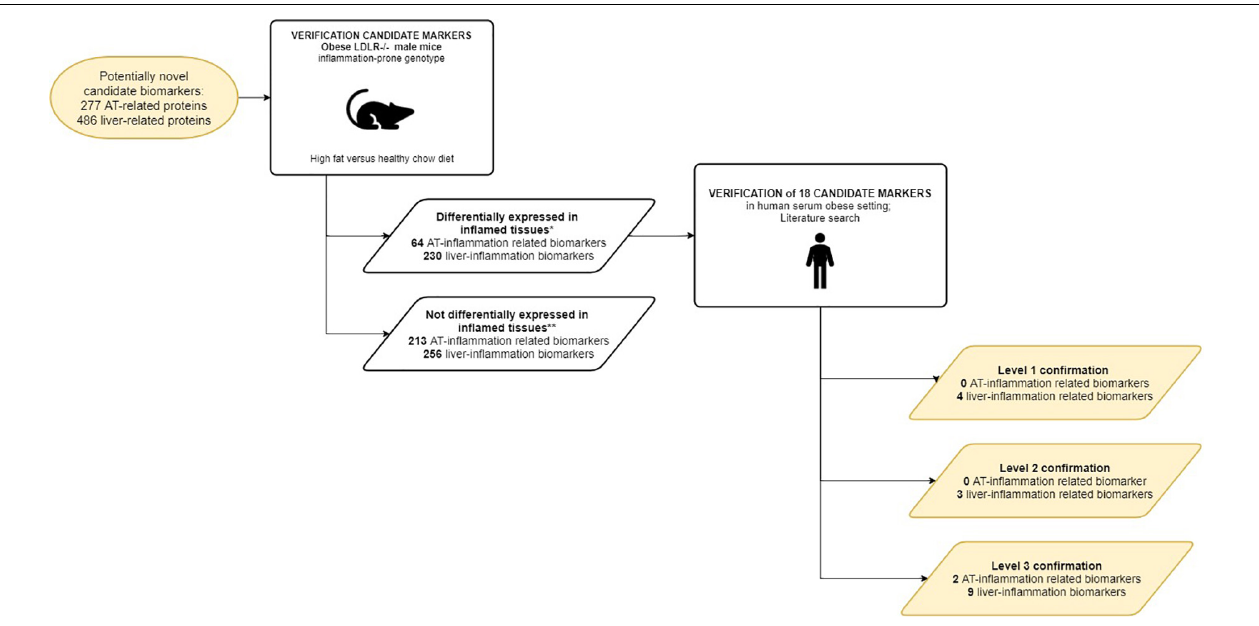
FIGURE 5 | Workflow of the verification of the curated candidate biomarkers. Curated candidate biomarkers were checked for up/down regulated gene-expression in WAT and livers of obese mice. The curated candidate biomarkers were divided into 2 groups: markers differentially expressed in inflamed tissues; markers not differentially expressed in inflamed tissues. *Cut-off criteria described in M&M; ** Due to absence of murine analog of human candidate biomarker and/or lack of (differential) expression in murine tissues in RNAseq experiment. TABLE 4 | Biological function of the 11 human candidate biomarkers with the highest level of confirmation (level 3). Biological function Candidate biomarkers Candidate biomarkers Correlated with hepatic inflammation Correlated with AT inflammation Remodeling extracellular matrix – Matrix metalloproteinase-9 (MMP-9) Lipid metabolism Resistin